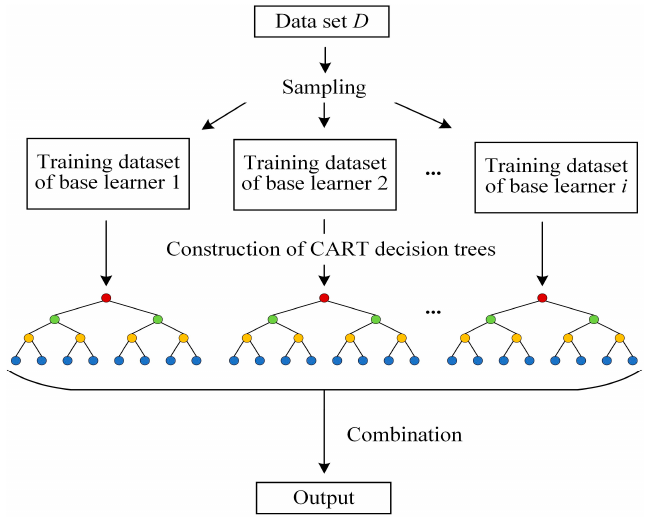
Figure 8. Schematic diagram of the RF for PD recognition.